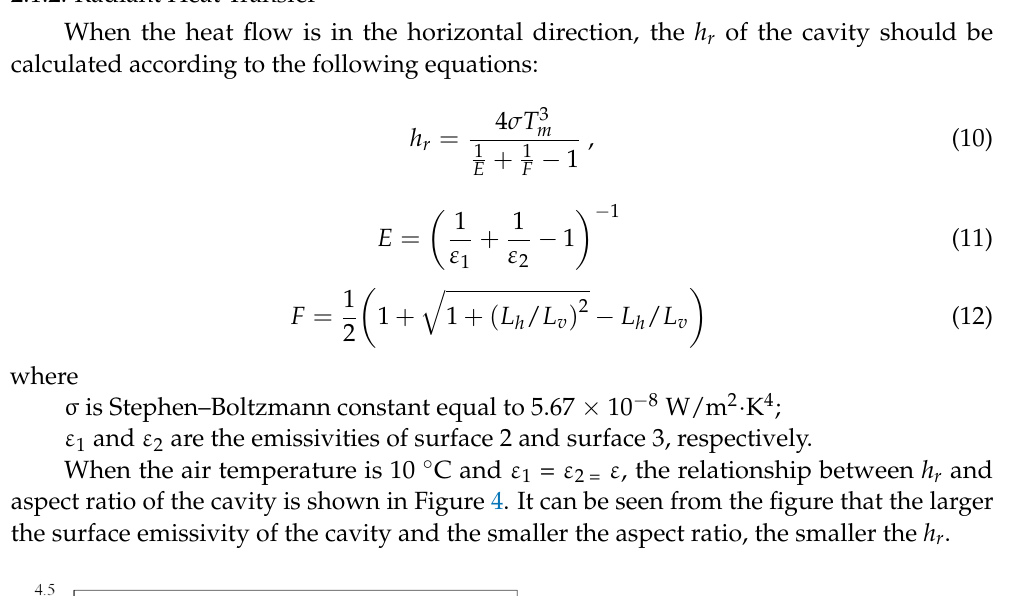
Figure 3. Relationship between cavity h c and width.